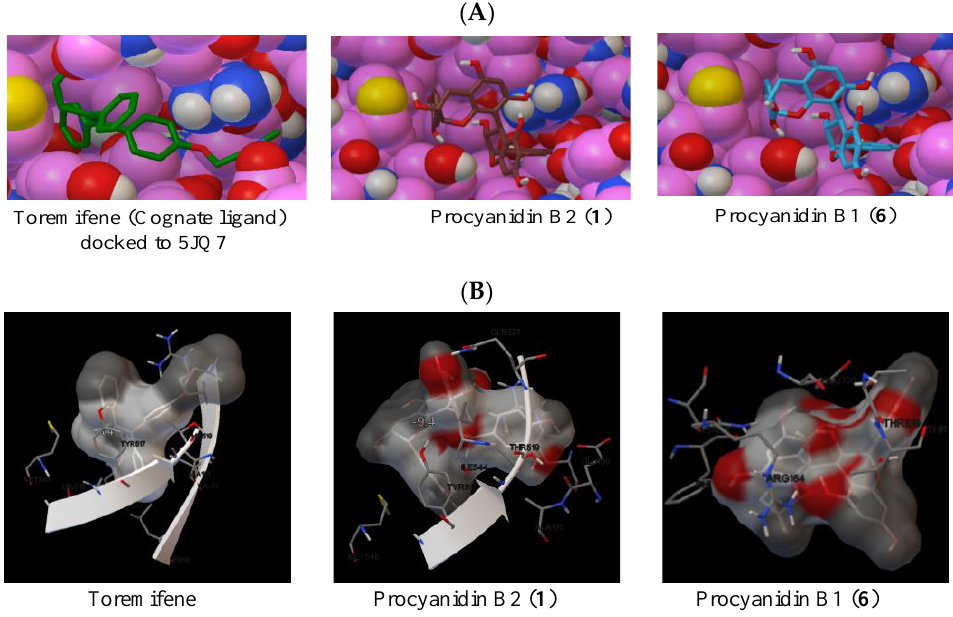
Figure 6. Molecular docking analysis of B-type procyanidins. ( A ) Docking result comparison of compounds 1 and 6 and toremifene in the binding site of the Ebolavirus glycoprotein crystal structure 5JQ7. ( B ) Binding modes of compounds 1 and 6 and toremifene. Table 2. The correlation between the docking score and the IC 50 values for B-type procyanidins, flavan-3-ols, and their analogues.